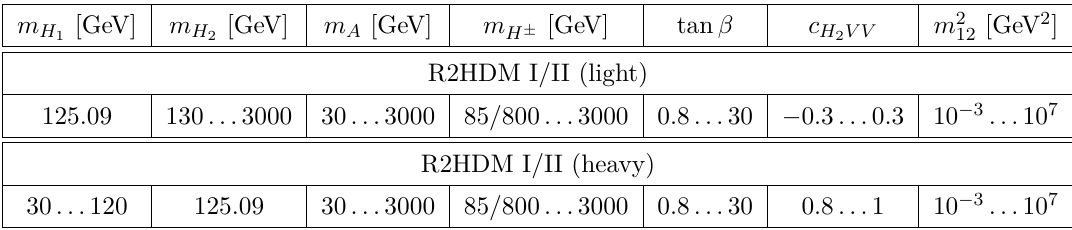
Table 2 . Scan ranges of the R2HDM input parameters, cf. eq. (2.7), where light (heavy) refers to the set-up where the lightest (heaviest) of the two CP-even neutral Higgs bosons is the SM-like Higgs H , i.e. H ( H ) ≡ H . SM 1 2 SM